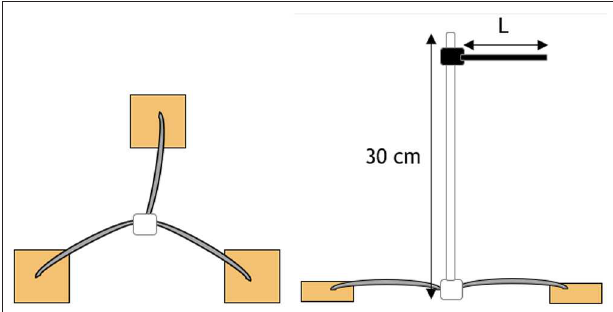
FIGURE 1 | Schematic of radial attachment of a sample triplicate. Triplicates are located 20cm below the surface with a color-coded cable tie located 10cm above the surface to indicate sample position and identification.